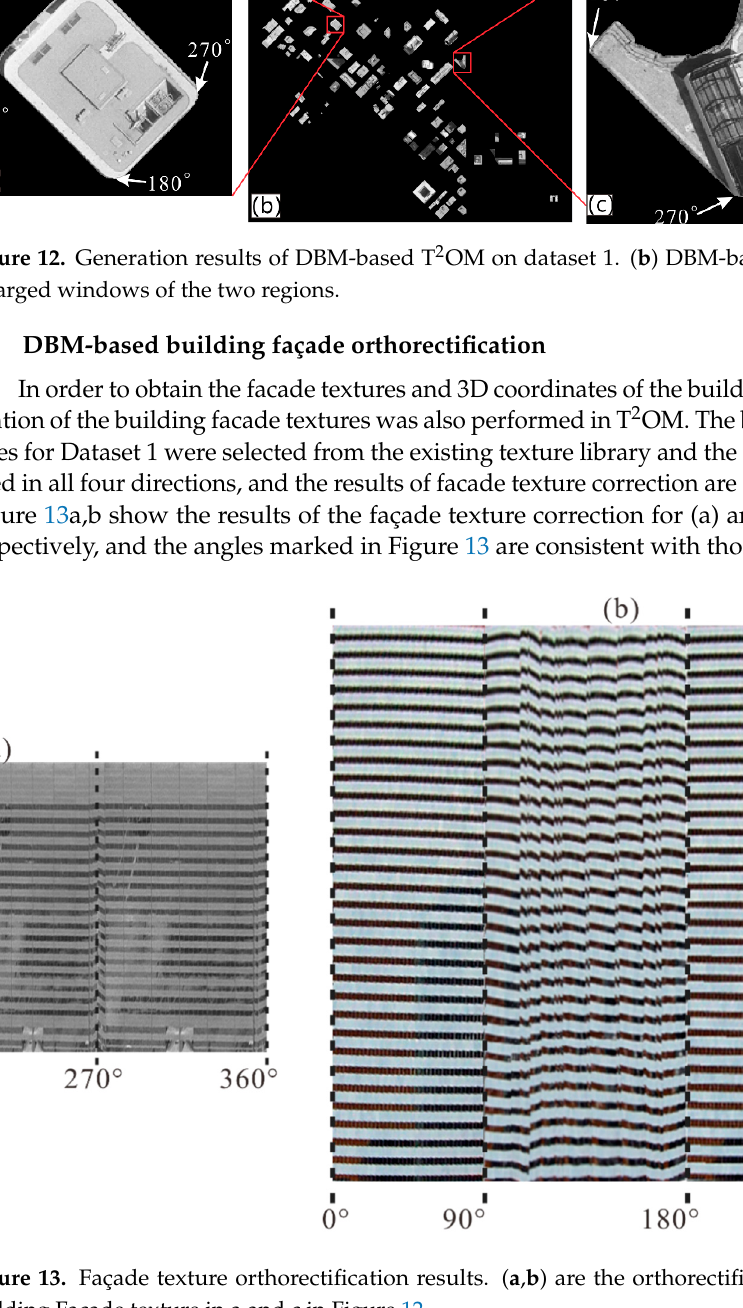
Figure 11. The experimental Dataset 1. ( a ) DTM data, where area ① and ② represent areas with- out elevation data; ( b ) Aerial image data; ( c ) DBM data.